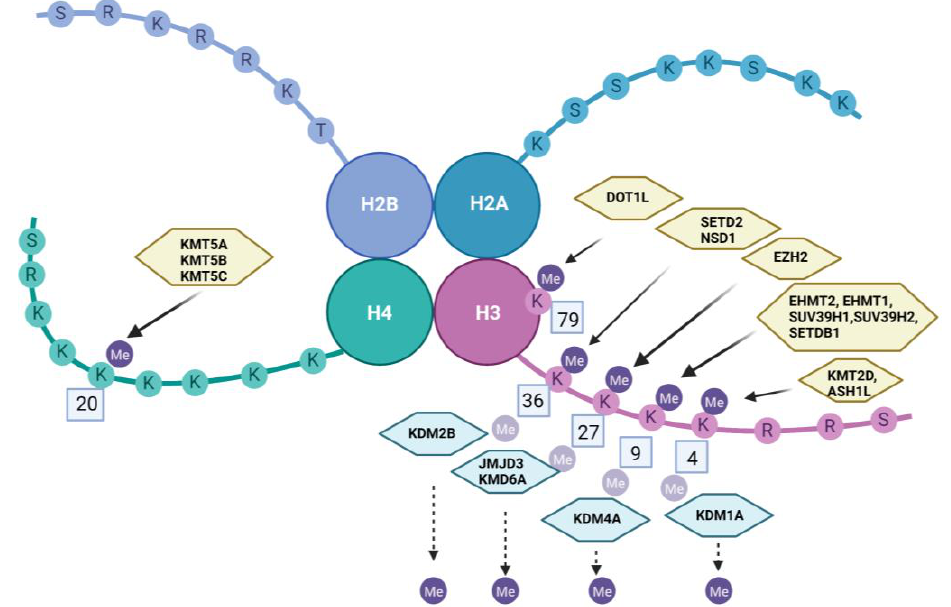
Figure 1. Methylation and demethylation of histones. Created with BioRender.com. Histone methylation has two effects: silencing signatures and actively transcribed